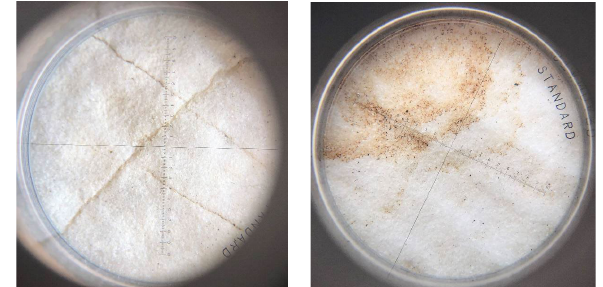
Figure 10 . Conducting the ultrasonic CT inspection on statue’s head. (Source: Tongji-ACL)